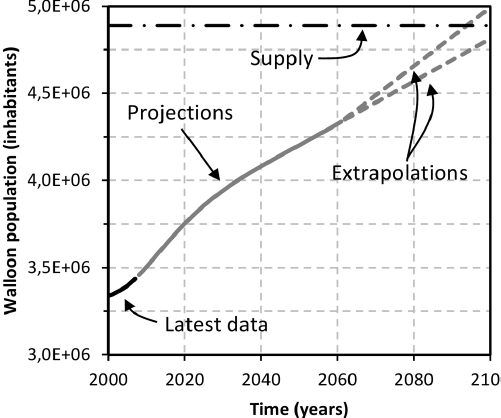
Fig. 5. Growth in urbanization of the 19 studied municipalities between 1997 and 2007. Urbanized area in 1997 for each municipality is 100.